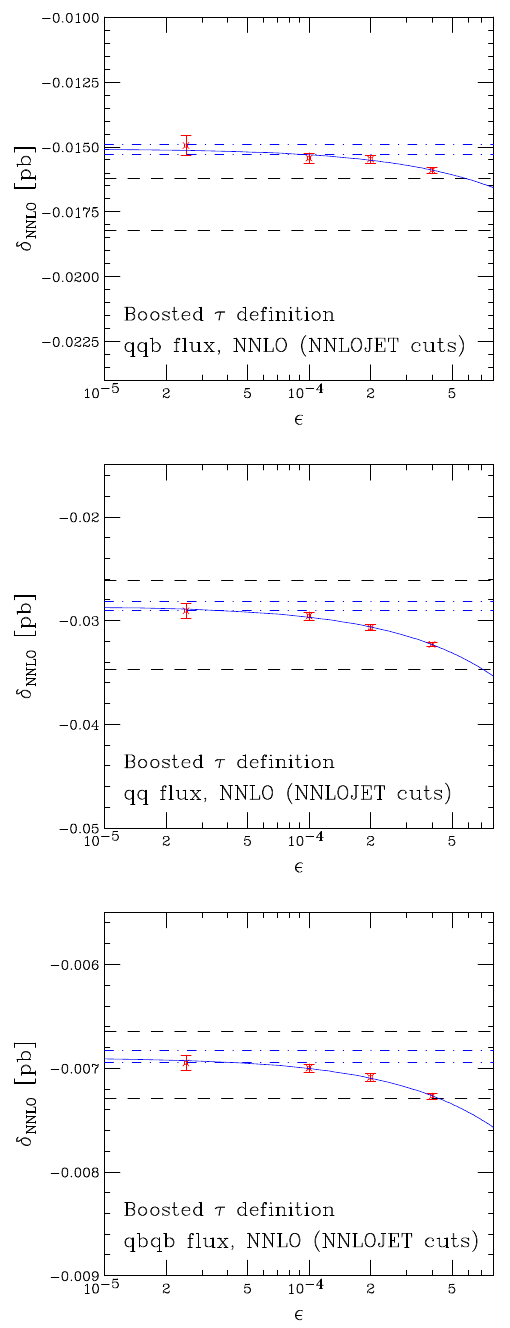
Figure 5 . (cid:28) -dependence of NNLO coe(cid:14)cients for the q (cid:22) q , qq and (cid:22) q (cid:22) q partonic channels, in the NNLOJET setup, using T 1 evaluated in the boosted frame. The (blue) solid lines correspond to the (cid:12)t form in eq. (3.6), with the dot-dashed lines representing the errors on the asymptotic value of the (cid:12)t. The NNLOJET result, including its associated uncertainty, is shown as the band enclosed by the black dashed lines.